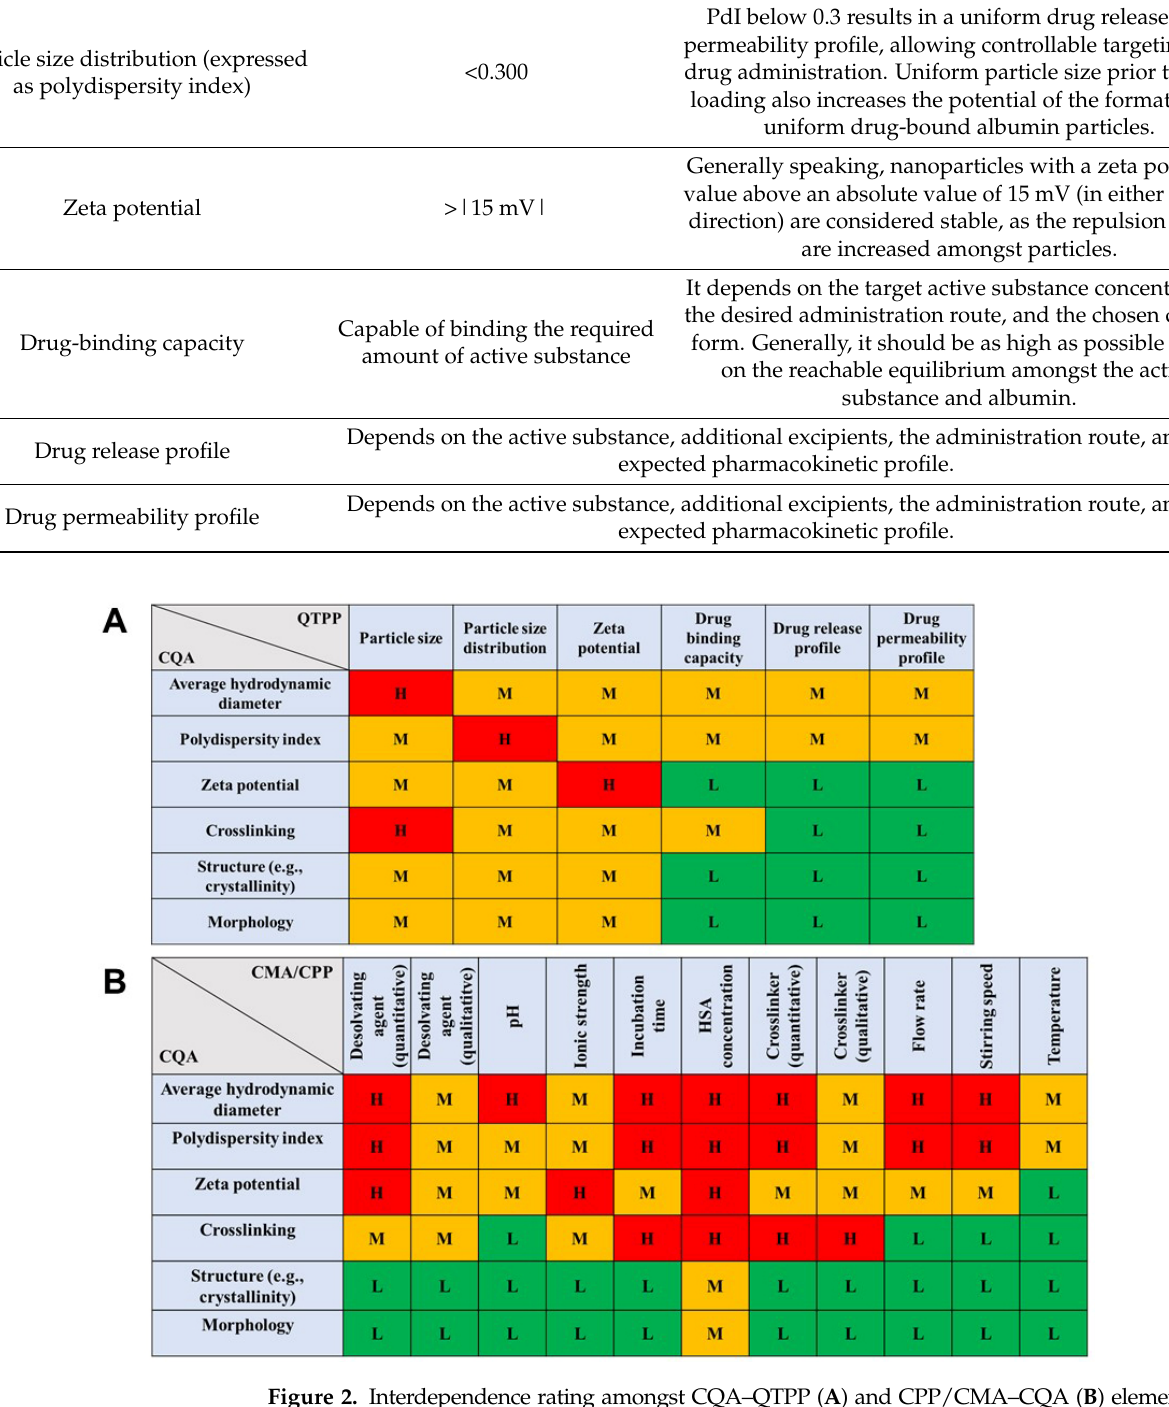
Figure 2. Interdependence rating amongst CQA–QTPP ( A ) and CPP/CMA–CQA ( B ) elements. The relations between the elements were assigned with “H”—high, “M”—medium, and “L”—low